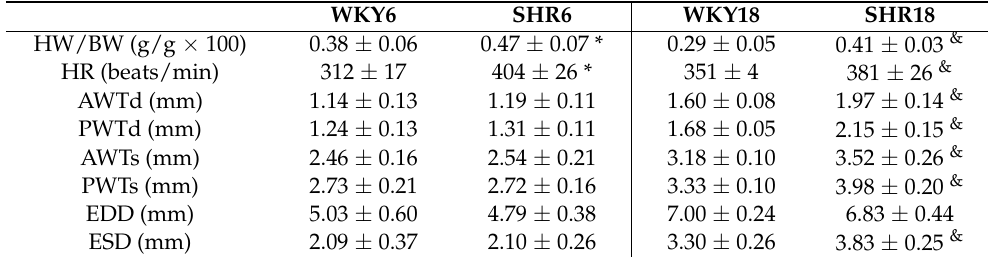
Table 2. Echocardiographic analysis of heart function and structure in WKY and SHR rats at 6 and 18 weeks of